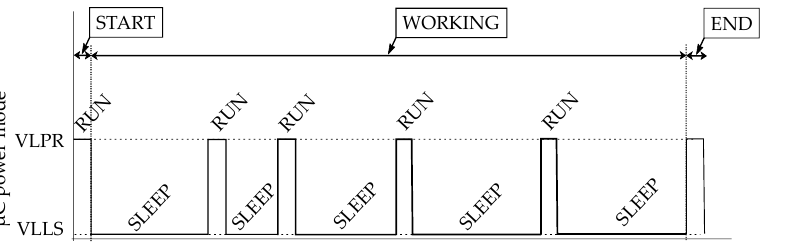
Figure 5. Sensor node phases for a generic experiment. Relationship with the microcontroller power modes: very-low-power run (VLPR)—corresponding to the RUN state—and very-low-leakage stop (VLLS)—the SLEEP state.